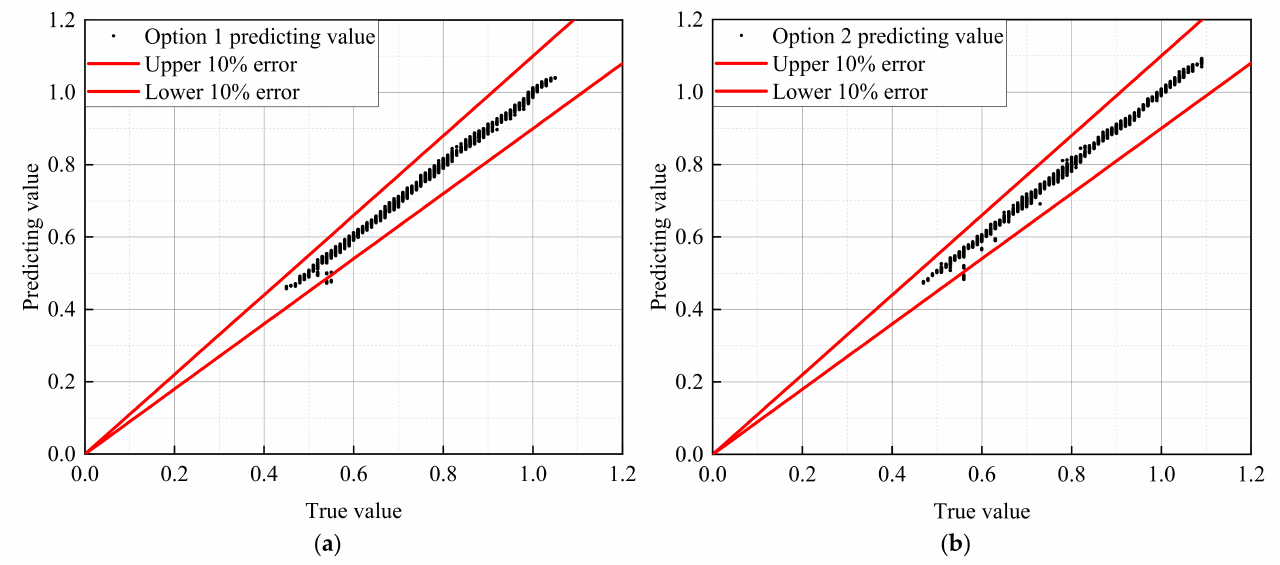
Figure 15. Evaluation prediction error diagram. ( a ) Option 1; ( b ) Option